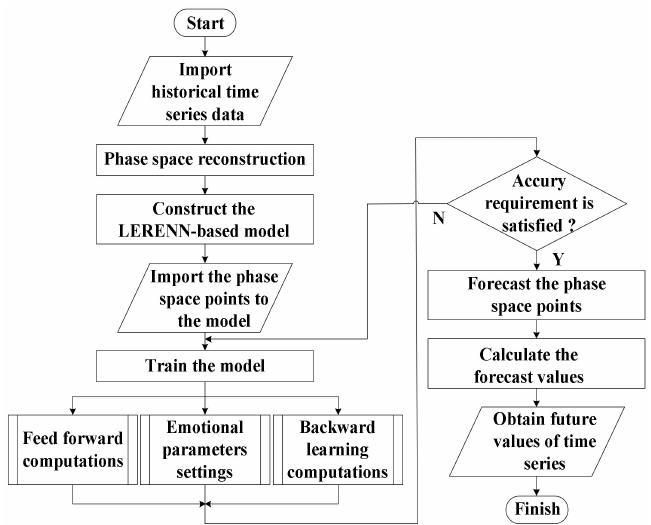
Figure 5. The flow chart of PV power ultra-short-term prediction based on